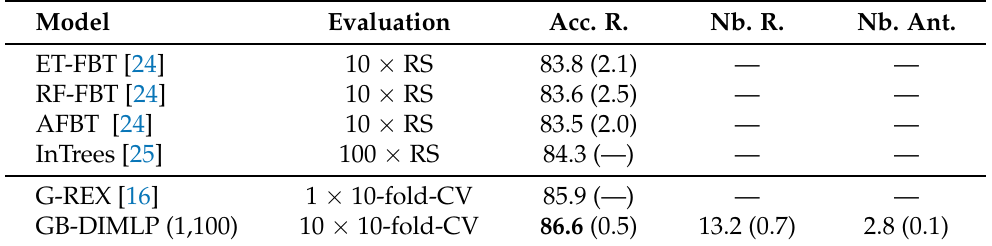
Table 12. Other results on the “Australian” dataset. A bold number represents a highest average accuracy of the